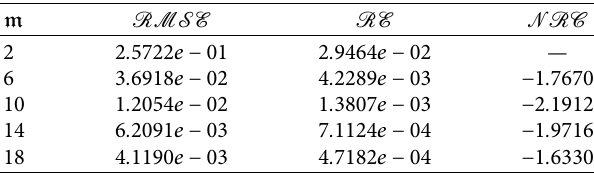
Table 5: RMSE , RE , and NRC for diferent m for Example